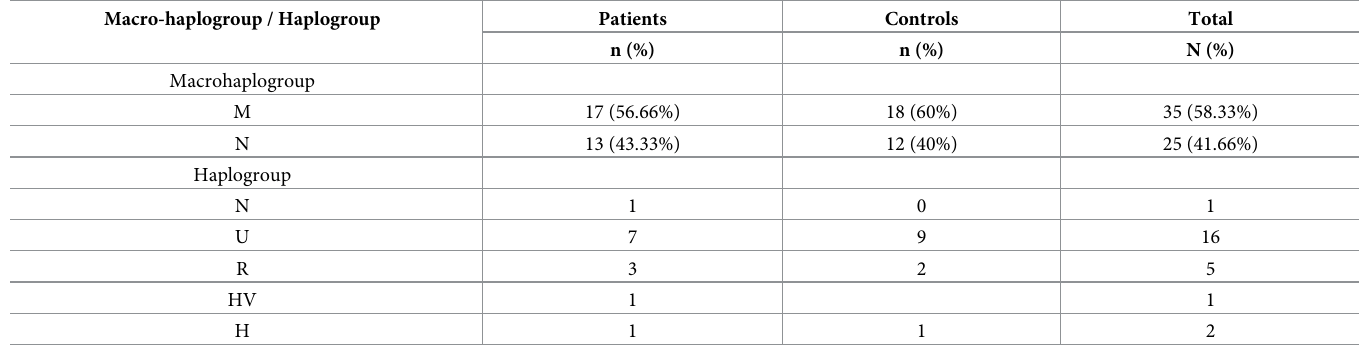
Table 4. Distribution of macro-haplogroups and haplogroups among the 30 matched pairs subjected to NGS analysis. Macro-haplogroup / Haplogroup